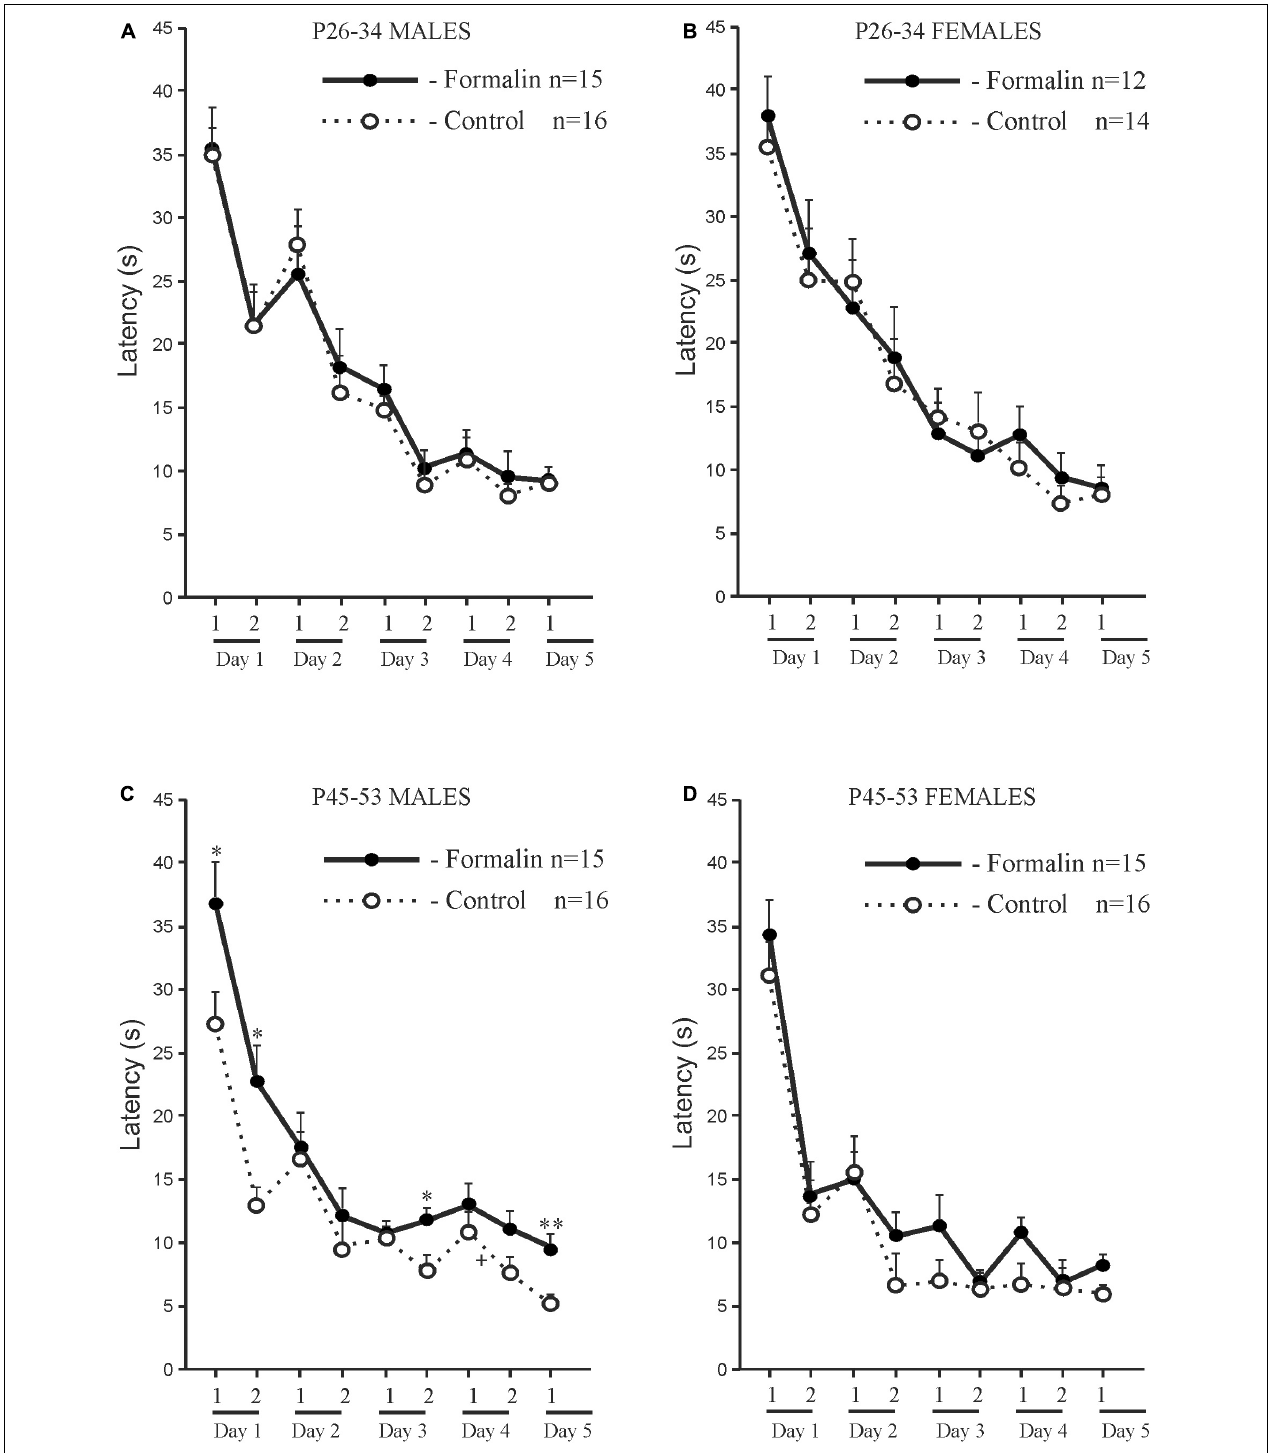
FIGURE 1 | Mean ( ± SEM) latency to find the platform in the first four training trials for 5 days and second four training trials for four training days of spatial learning in Control and Formalin male and female rats of early (P26-34) and late (P45-53) age groups. Panels (A,B) show data for male and female rats at the early age group. Panels (C,D) show data for male and female rats at the late age group. The abscissa shows the first and second training four trials (1 and 2) in each of the five training days. + p < 0.05, ++ p < 0.01, +++ p < 0.001 significant differences in Control rats between the first four training trials and the second four training trials each day. ∗ p < 0.05, ∗∗ p < 0.01 Formalin rats vs Control rats.